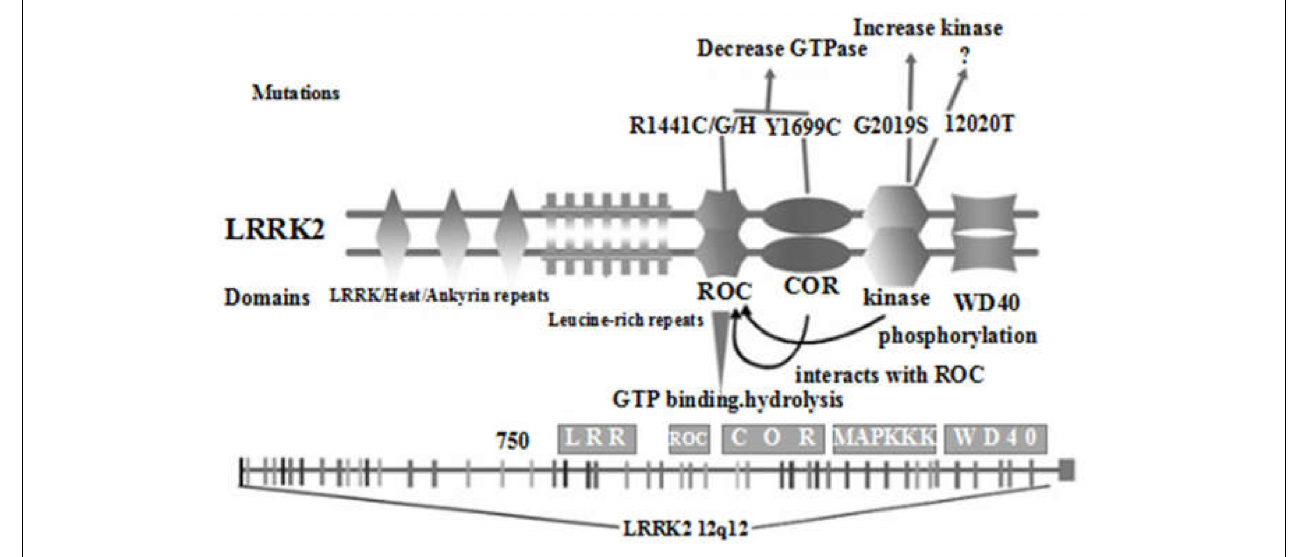
FIGURE 1 | Schematic diagram of the distribution of the main domains of LRRK2 protein and the location of current important mutations (Re-creation based on Cookson, 2010 and Mata et al.,